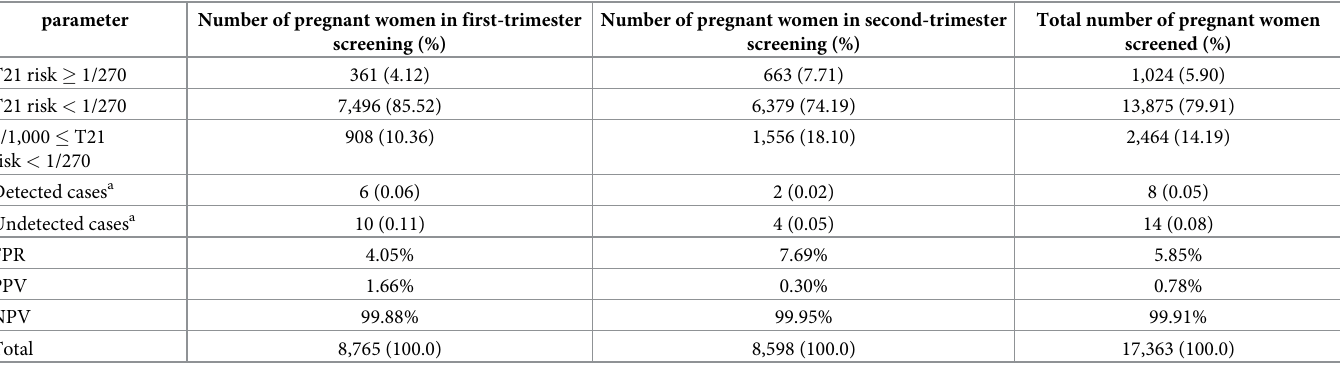
Table 1. List of Serum screening results.